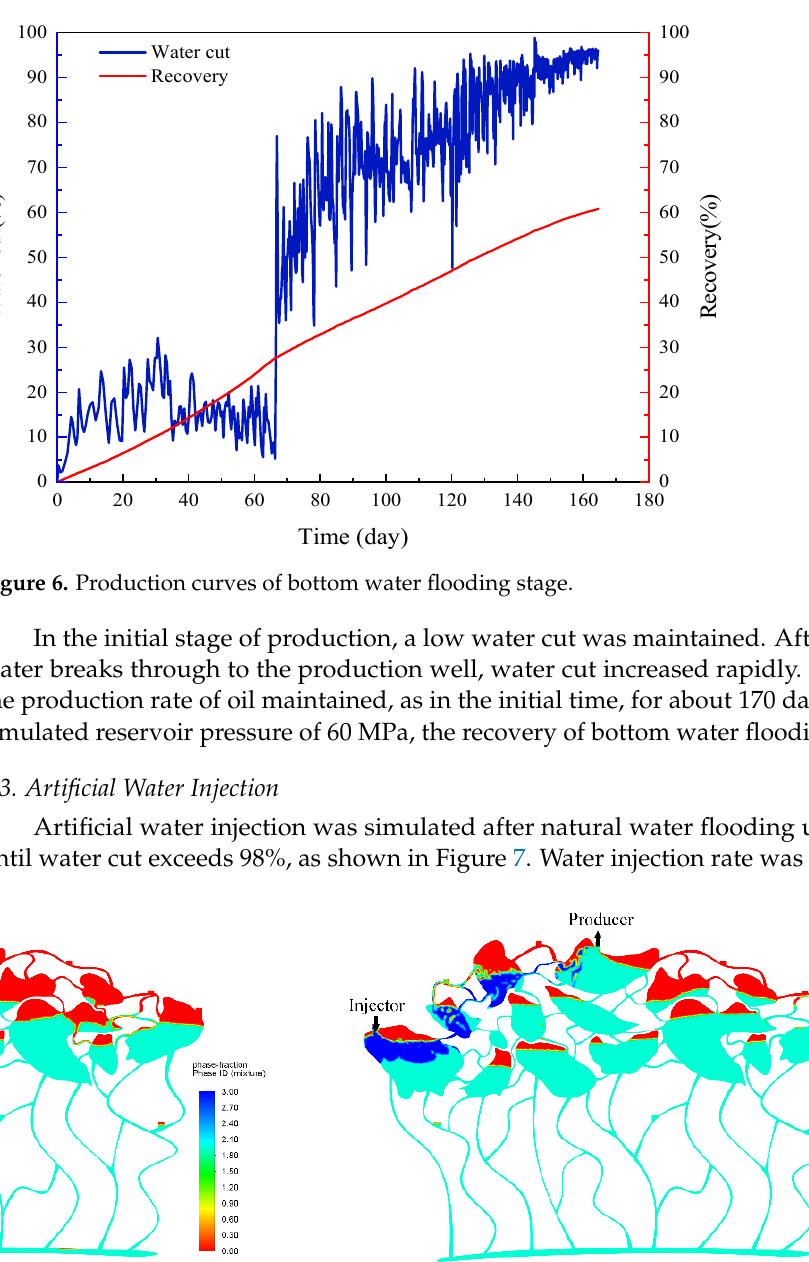
Figure 7. Fluid distribution in different displacement stages of water injection: ( a ) initial stage; ( b ) last stage. It can be observed that the injected water in the middle and lower parts of the model migrated downwards under the action of gravity, and the lateral movement also occurred under the resistance of the bottom water. In this process, the remaining oil flowed together with water to the production well, the injected water wave expanded to other fracture– cavity structure (Figure 7 right, dark blue zone), and an oil–water interface, distributed along the connection line of injection and production wells, was gradually formed [9]. At the end of water injection, the remaining oils were mainly distributed in the higher part of the structures. The water cut curve showed the characteristics of first decreasing fol- lowed by increasing (Figure 8). This was expected, as water injection swept some new zones and displaced some remaining oil in the initial stage, while water channeling oc- curred in the middle and late stages of water injection, making the water cut increase